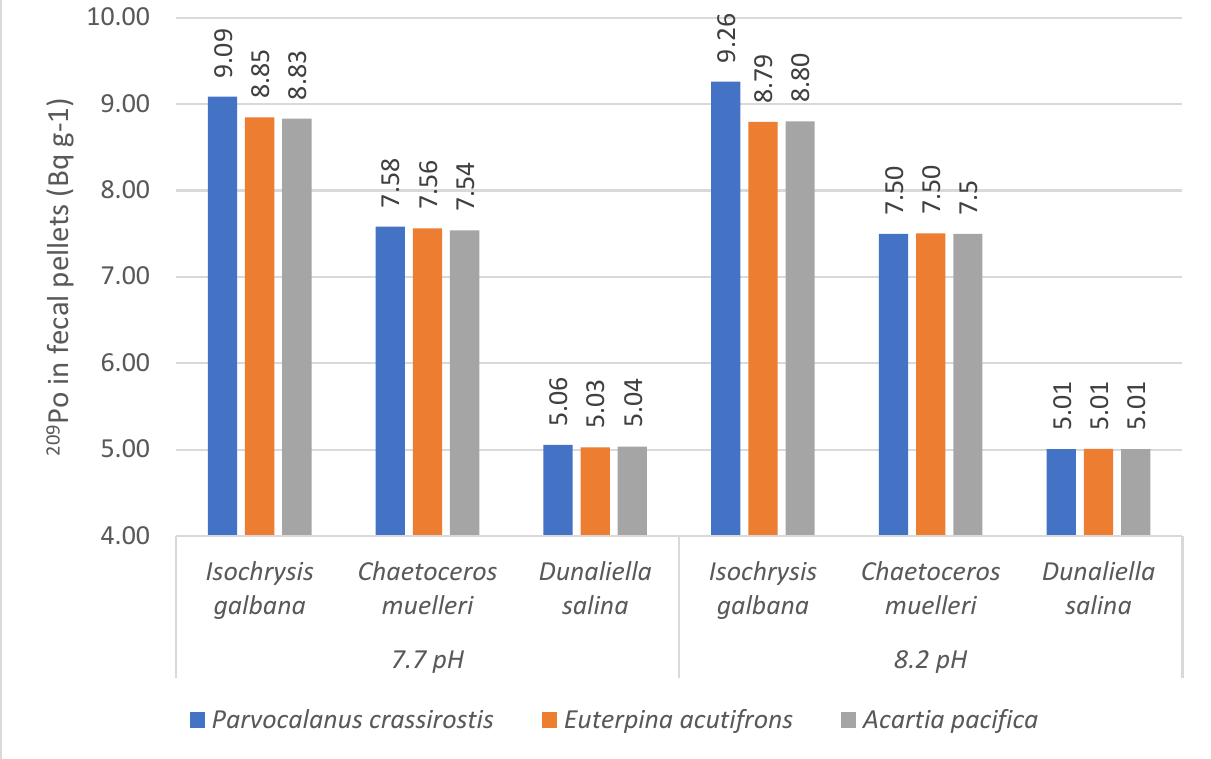
Figure 6. Average 209 Po concentration in fecal pellets at 7.7 and 8.2 pH in three copepod species for the three algal feeds.